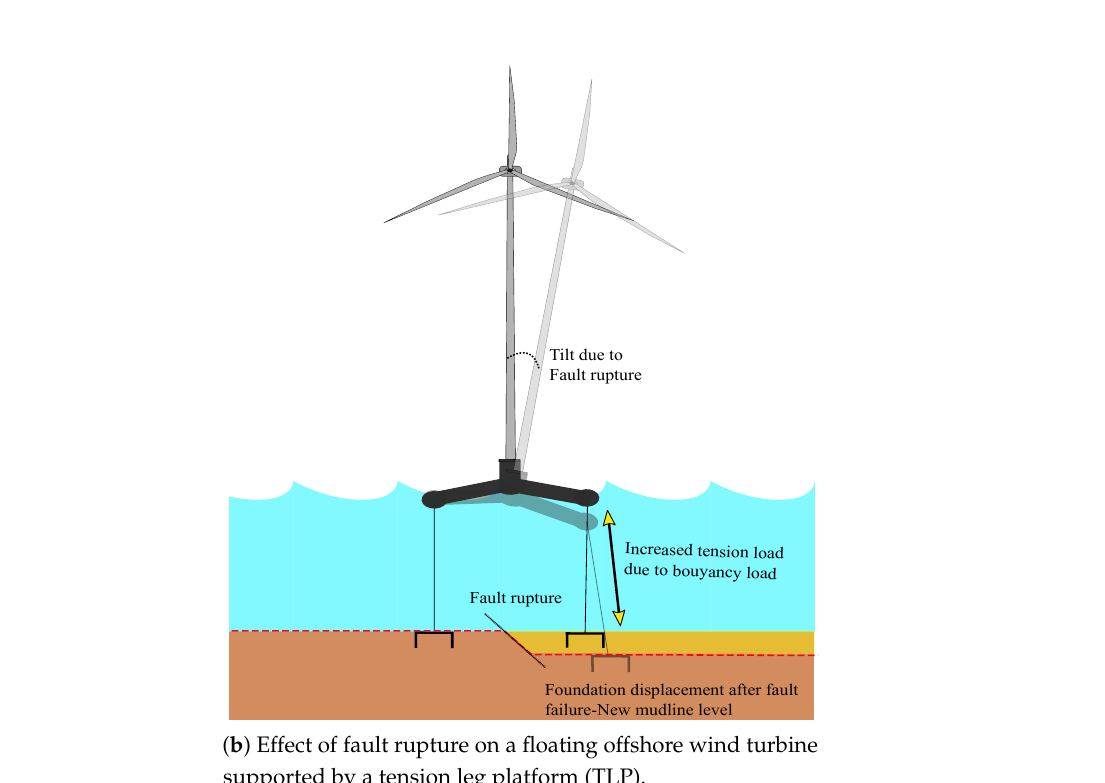
Figure 4. Effect of fault rupture on floating wind turbine system. Earthquake hazards to a wind farm can be complex and it is considered useful to discuss further. Figure 5 shows a schematic of a wind farm with grounded systems.